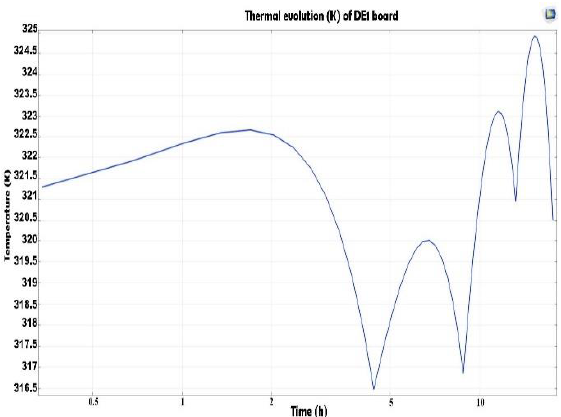
Fig. 4 . Thermal evolution of the Altera board versus